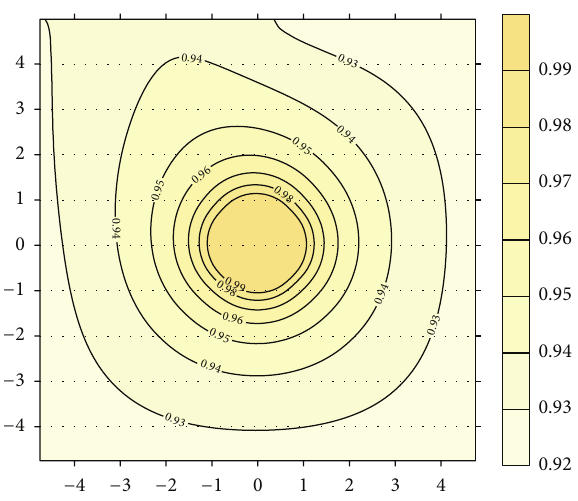
Figure 20: Profile compaction degree and its scope.